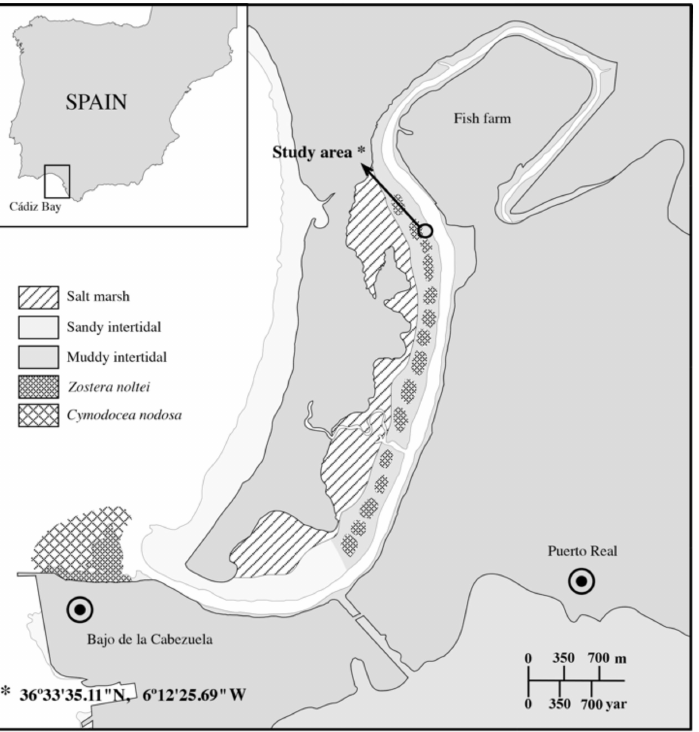
Figure 1. Location of the in situ experiments. Main characteristics (vegetation and type of sediment) and the situation of an aquaculture plant are indicated in the map. Asterisk indicates study